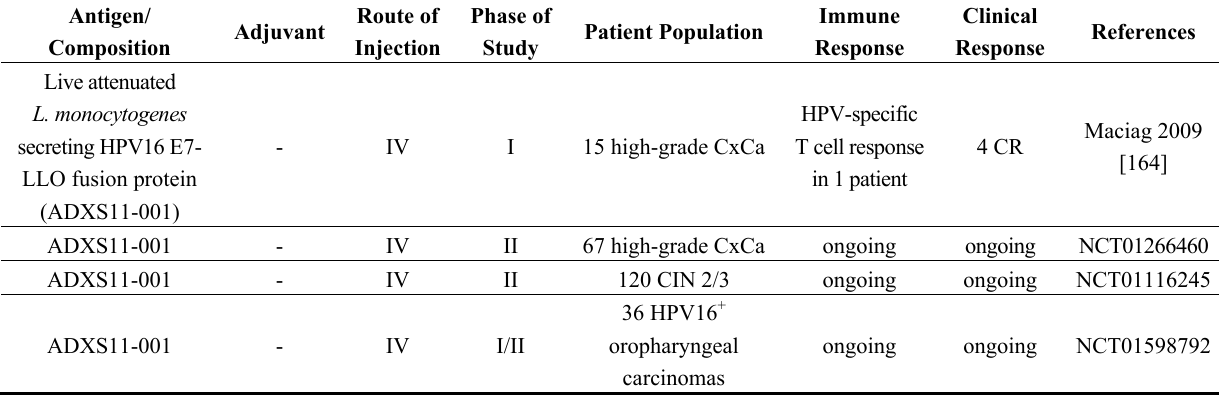
Table 6. Clinical studies with bacterial vector